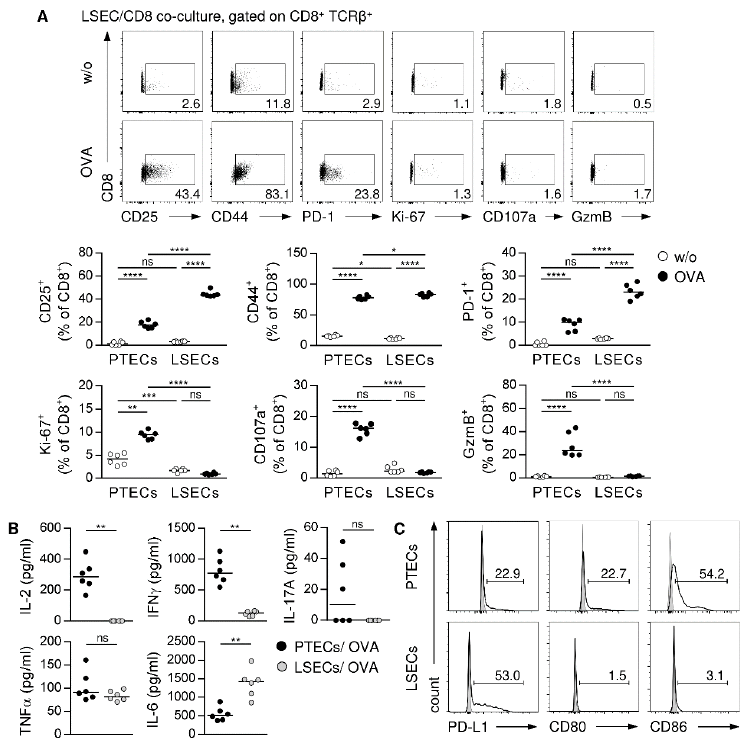
Figure 5. Phenotype analysis of CD8 + T cells activated by PTECs or LSECs. OVA-specific CD8 + CD25 − T cells were cultured with PTECs or LSECs in presence or absence of OVA for 5 days. ( A ) CD8 + T cells from co-cultures were stained for CD25, CD44, PD-1, Ki-67, GzmB, and CD107a and analyzed by flow cytometry. ( B ) Cytokine levels were determined in co-culture supernatants. Representative dot plots of LSEC/CD8 co-cultures and medians of two experiments are shown. ( C ) PTECs and LSECs were stained for PD-L1, CD80, and CD86 and analyzed by flow cytometry. Representative dot plots of two experiments are shown. * p < 0.05; ** p < 0.01; *** p < 0.001; **** p < 0.0001; ns: not significant; w/o: without